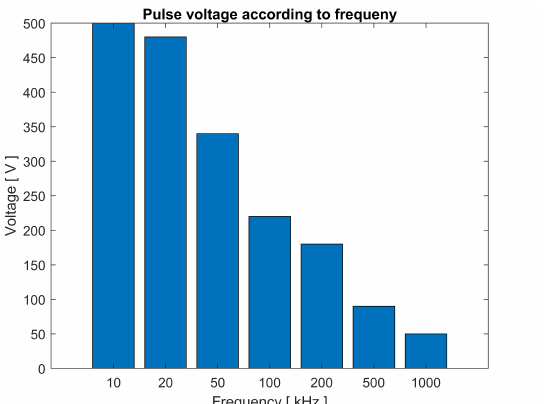
Figure 11. Pulse voltage obtained according to application frequency, with 4 V at the source and separation of 0.1 mm between